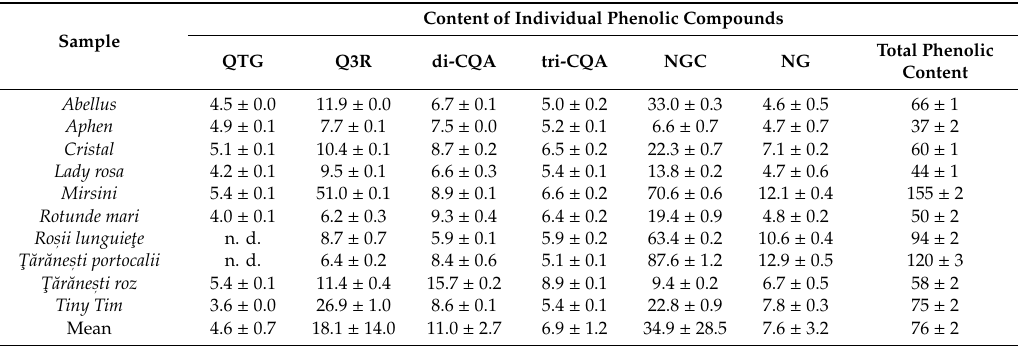
Table 2. Individual concentrations of phenolic compounds and total phenolic content of ten tomato varieties peels extracts (mg / 100 g DW) ±